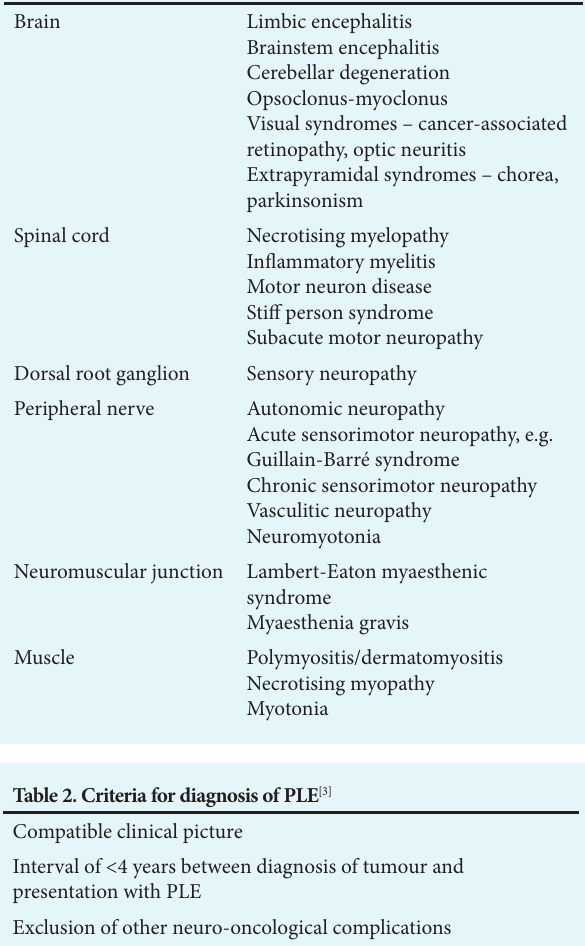
Table 1. Location of paraneoplastic neurological syndrome and subtypes described